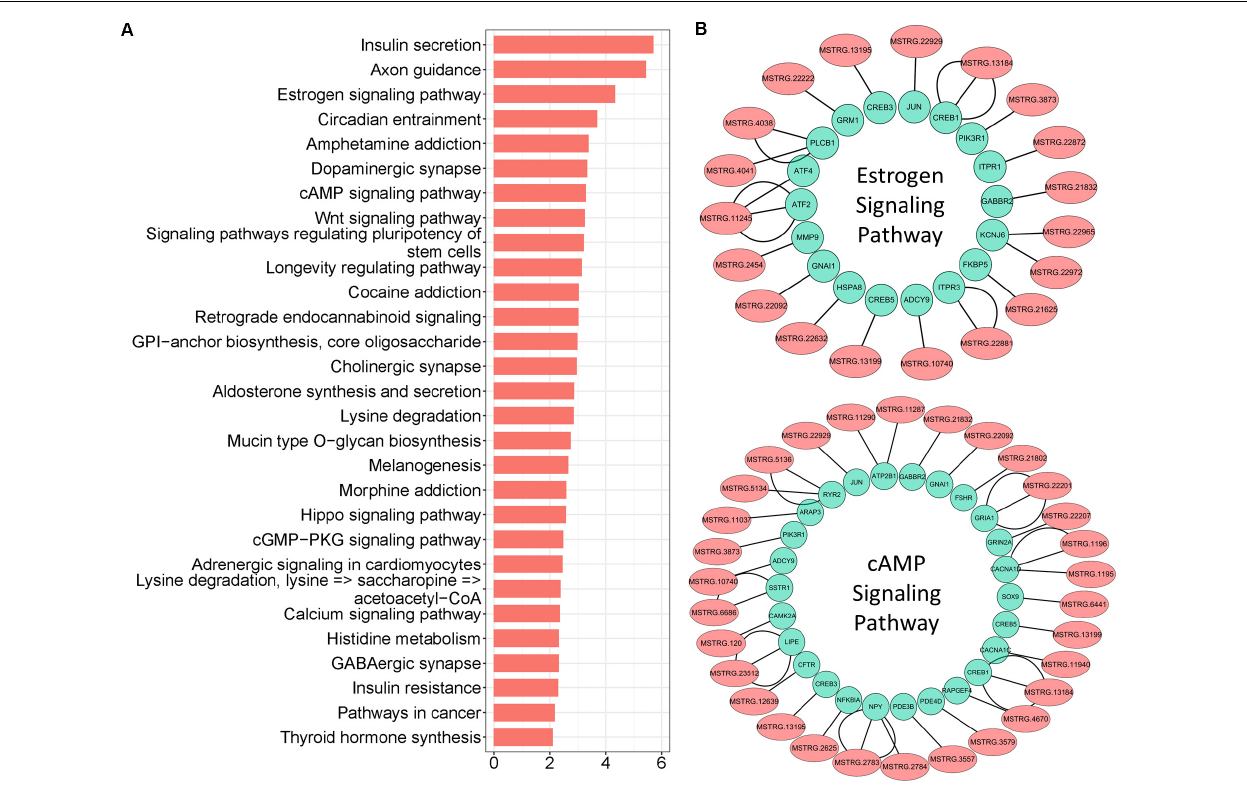
FIGURE 5 | Pathway enrichment analysis of key cis -lncRNA targeted genes. (A) Pathway enrichment of key cis -lncRNA targeted genes. The x-axis text represent the value of “-Log( p -value)”. (B) The cis -regulatory networks of lncRNA–mRNA for estrogen and cAMP signaling; lncRNAs are marked with light coral nodes and targeted genes with light green; the inter-line represents targeted